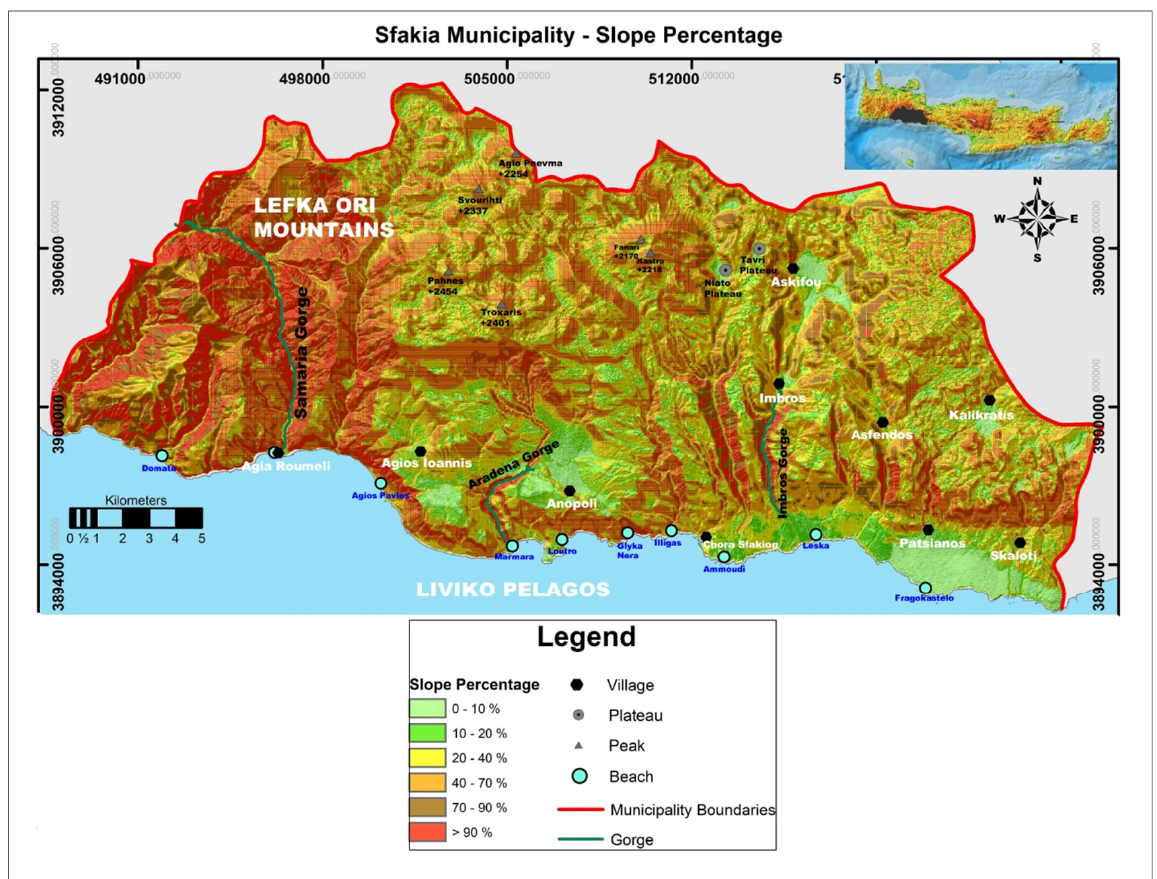
Figure 6. Percentage slope map of the Sfakia Municipality. The map was formed in the frame of this study and highlights the steep terrain that dominates the area, especially in the western part, and along the big gorges as well.